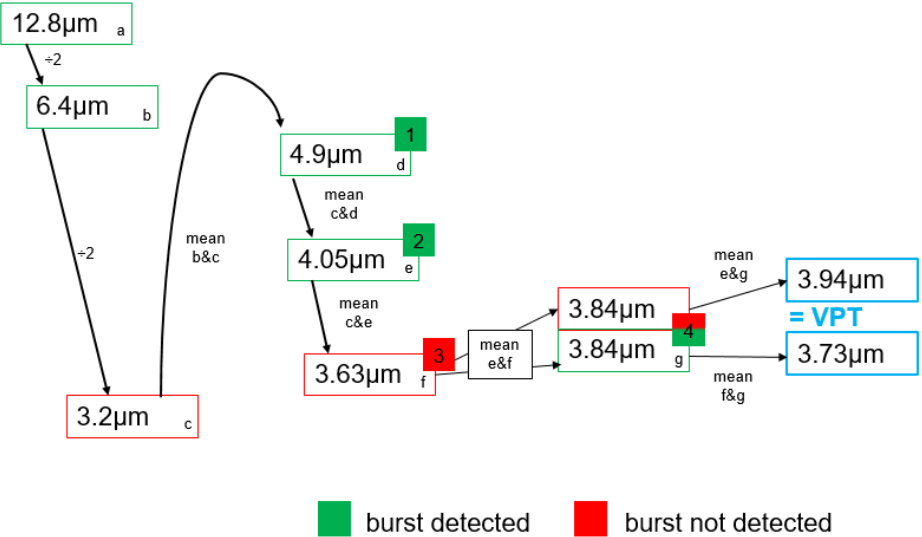
Figure A1. Visualization of the measurement algorithm. Each measurement trial starts with a clearly detectable vibration stimulus ( a ). If the subject feels the applied vibration, the measurement algorithm halves the next stimulus to be tested ( b ). As soon as the first vibration can no longer be perceived ( c ), the algorithm averages the last stimulus felt ( b ) and the last stimulus not felt ( c ). Stimulus ( d ) was felt again so that stimulus ( e ) is calculated as the average of the stimulus amplitudes of ( c ) and ( d ). Stimulus ( f ), calculated as the average of vibration ( c ) and ( e ), was again not perceived, so that in the next step the algorithm calculates the average of stimulus ( e ) and ( f ) and applies stimulus ( g ). Depending on whether the participant can perceive this last vibration stimulus, the algorithm calculates the final VPT. After the first non-perceived stimulus, the algorithm applies a maximum of four more vibrations. Thus, the measurement duration is limited to approx. 1 min per measurement run. The pause length between vibration stimuli varies randomly between two and seven seconds.